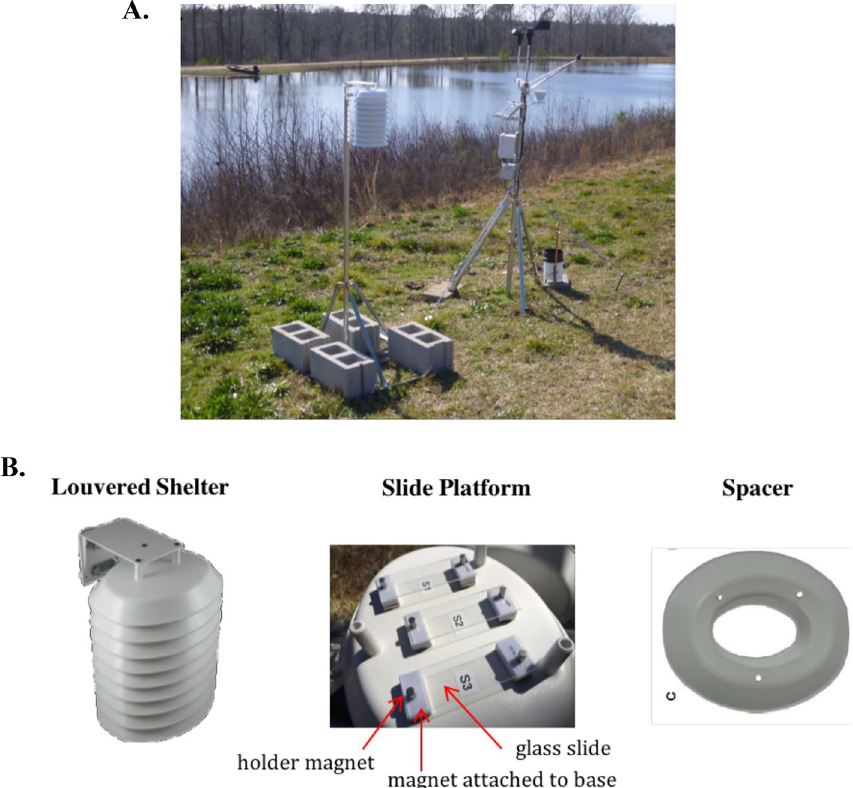
Figure 7. Settled airborne dust collection station. ( A ) Photo from the South Carolina dust collection site of EZ-NPP tripod secured with cinder blocks holding an assembled Ambient Weather SRS100LX radiation shield (louvered shelter). Also pictured is an Onset HOBO U30-RNC Weather Station. ( B ) Diagram of a louvered shelter. A slide platform was created by mounting 6 magnets spaced appropriately to serve as slide holders into a base (center). Clean slides were secured into the holders with additional small magnets. Each complete louvered shelter (left) consisted of 3 sets of a slide platform underneath two spacers (right) added for additional air